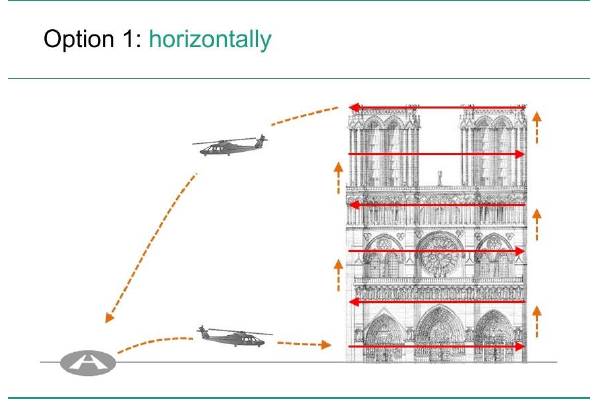
Figure 2. Horizontally aligned building flight pattern